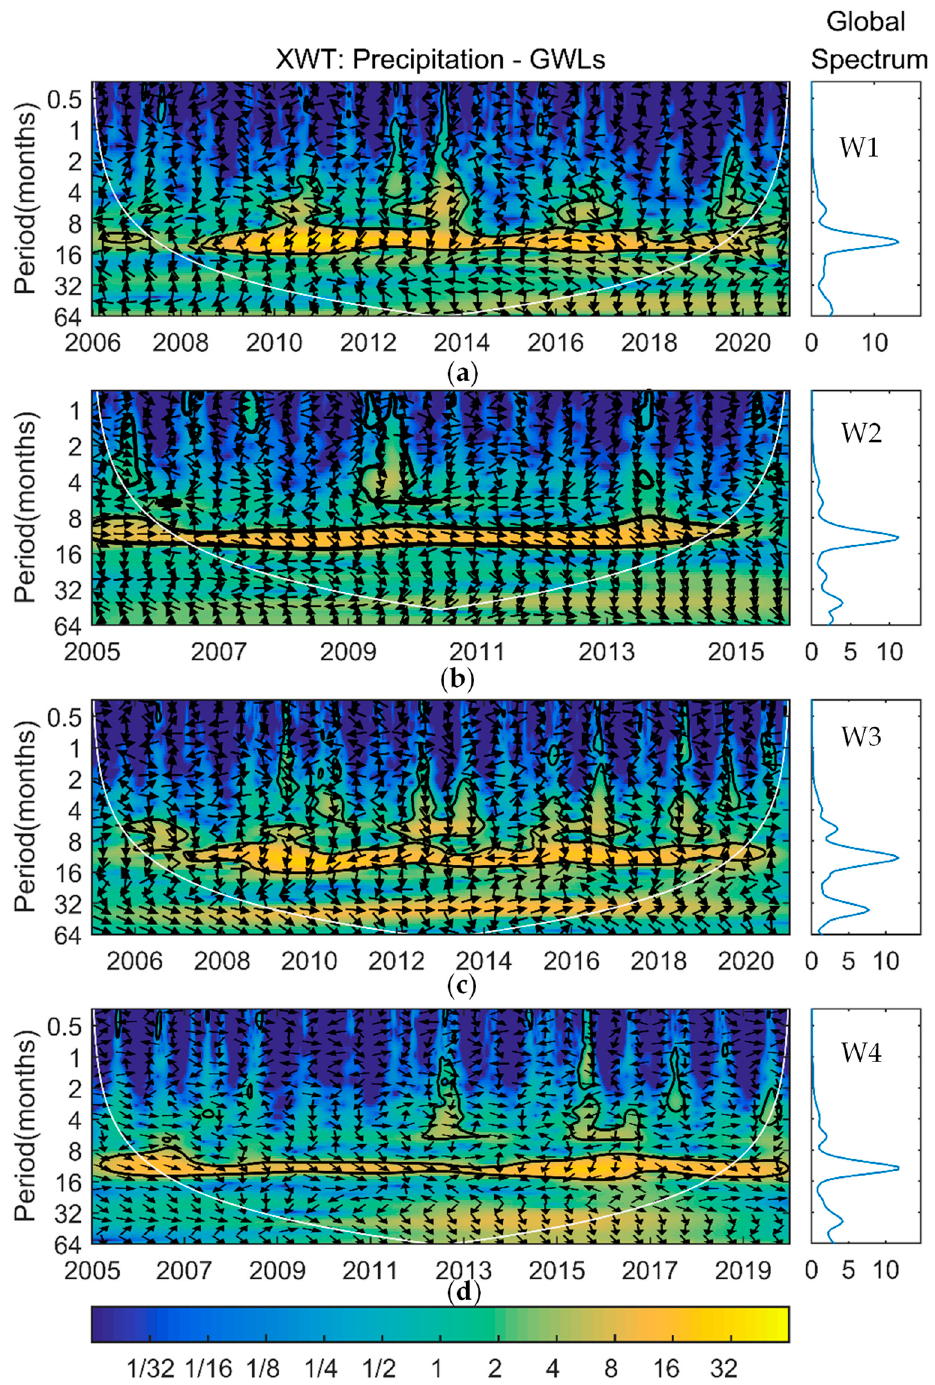
Figure 7. Cross wavelet spectra (left) with global wavelet spectra (right) between rainfall and GWLs at ( a ) W1, ( b ) W2, ( c ) W3, and ( d ) W4. Zones surrounded by black lines have significant wavelet power at the 95% confidence level. White lines denote the cone of influence. The phase angles are indicated by the black arrows.